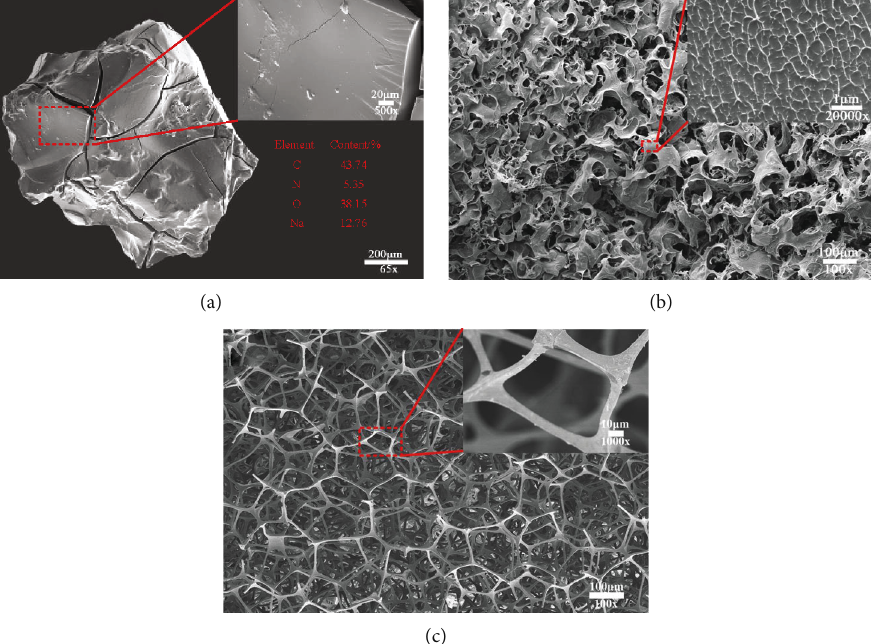
Figure 3: SEM images of (a) dried P(AANa/AM) particles, (b) P(AANa/AM) immersed in MB solution, and (c) the sponge.